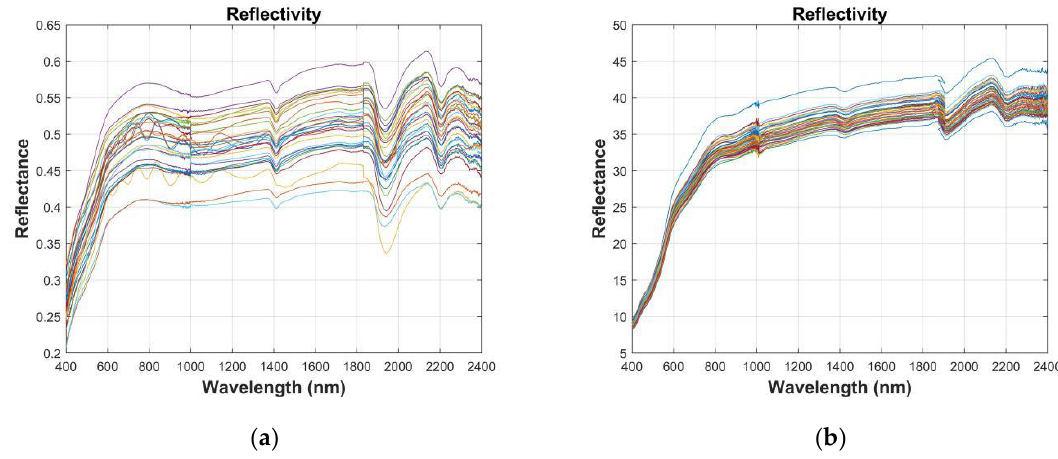
Figure 2. Soil reflectance spectra (with fringe noise removed): ( a ) northwest China and ( b ) Honghu.